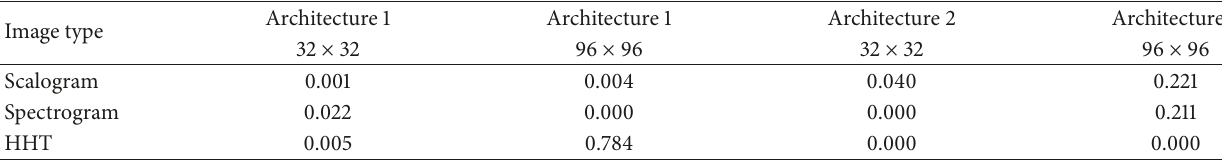
Table 20: CWR paired two-tailed 𝑡 -test 𝑝 values.